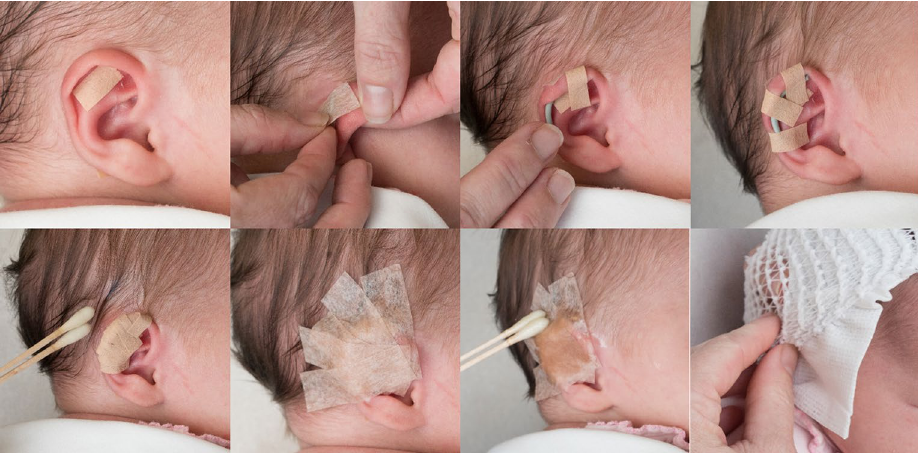
Figure 5. Representation of our ear molding process during